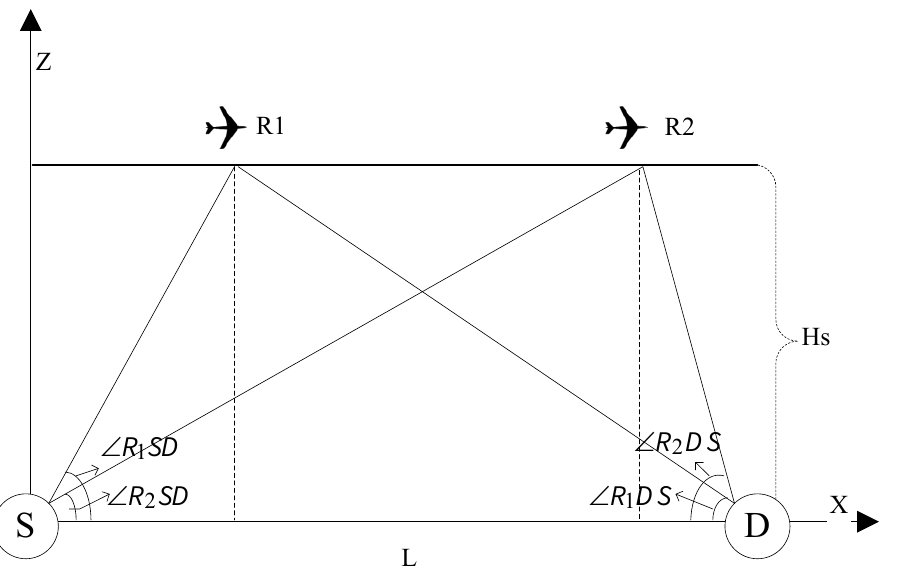
Figure A1. Schematic for the proof of Lemma